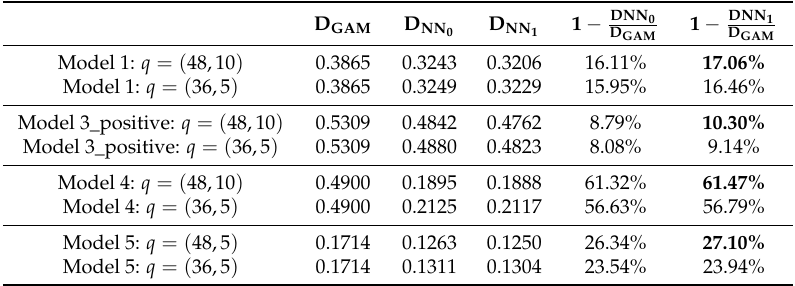
Table 2. Minimal cross-entropy and deviance loss functions on validation sets observed during the training of the neural networks in k = 2.